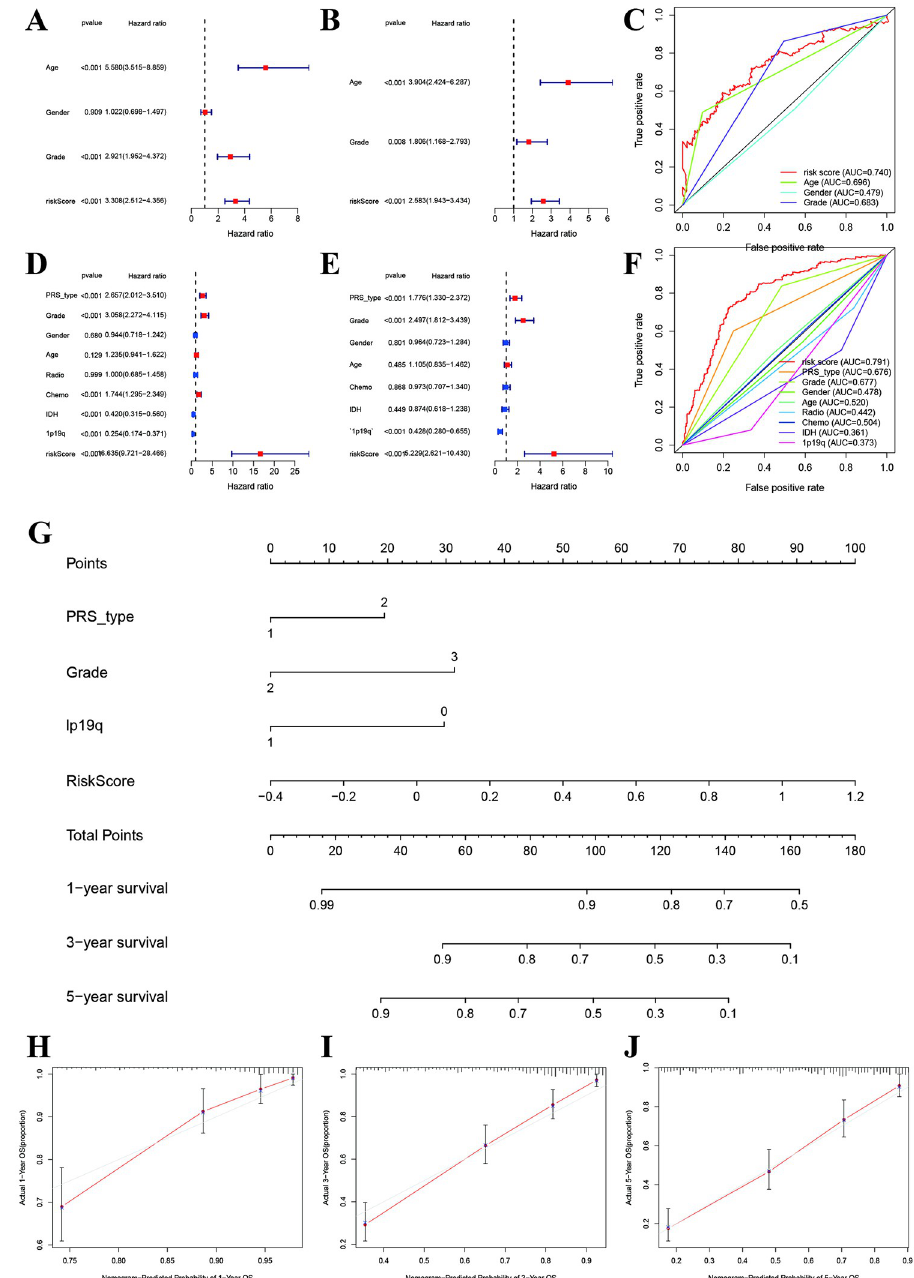
Fig 5. Risk assessment system for induvial prognosis. A and B: univariate and multivariate cox regression of risk score for prognosis prediction in TCGA. C: Multi-ROC comparisons for predicting prognosis in TCGA. D and E: univariate and multivariate cox regression of risk score for prognosis prediction in CGGA. F: Multi-ROC comparisons for predicting prognosis in CGGA. G: Nomogram risk assessment system for individual prognosis. H, I and J: Calibrations fitting plots between actual and predicted probability at 1-year, 3-year, and 5-year.